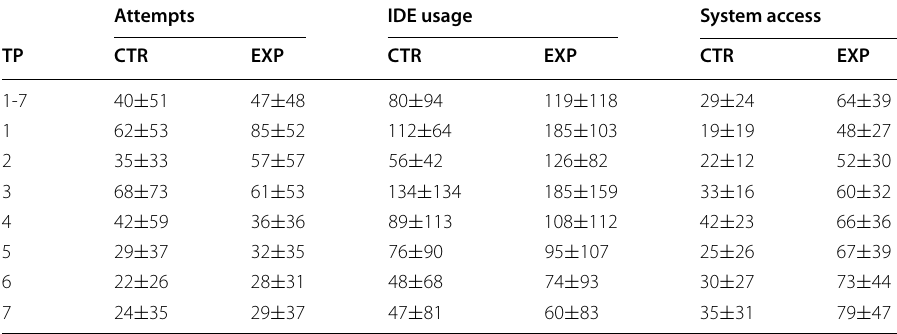
Table 2 Descriptive statistics for behavioral outcomes of participants from control (CTR; non- gamified) and experimental (EXP; gamified) conditions for seven time-points (TP) of the semester, as well as overall (1-7). Data represented as Mean Standard ±